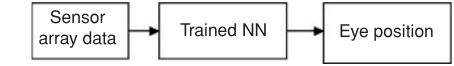
Figure 14 The fusion block diagram.